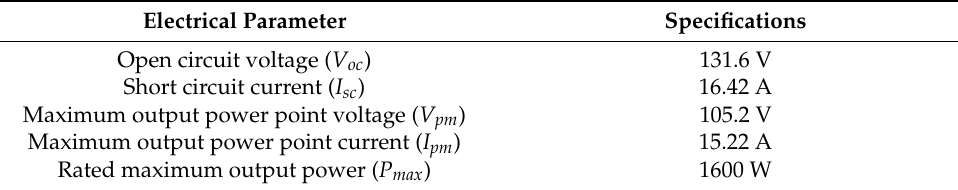
Table 3. Electrical specifications of KYOCERA KC200GT